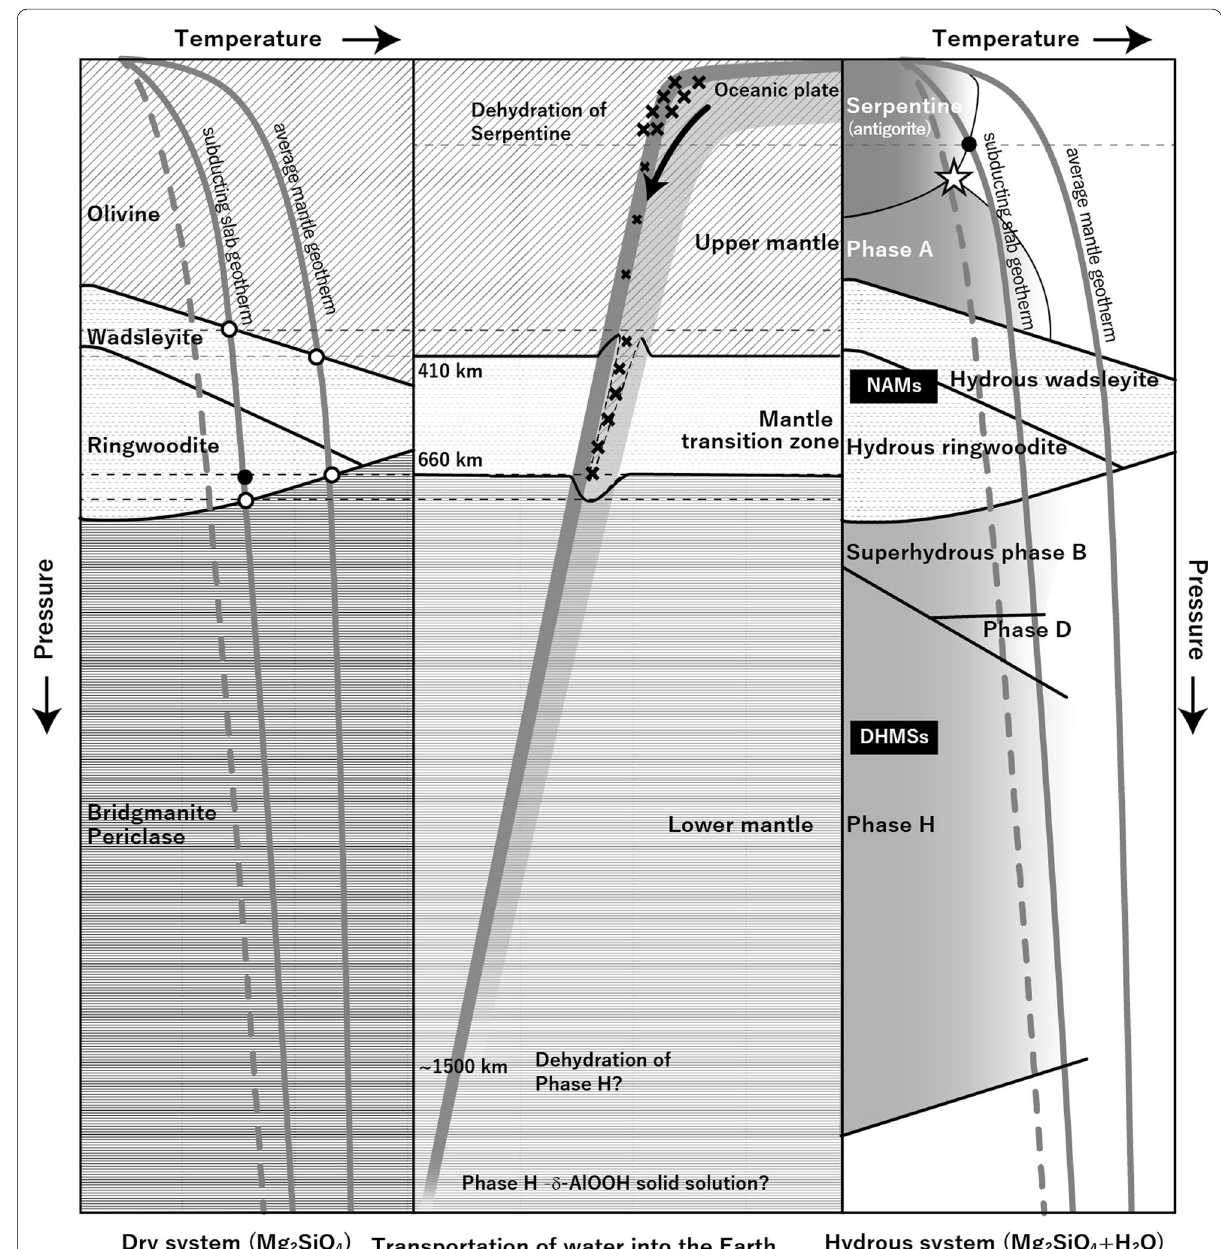
Fig. 1 Schematic illustration of the subducting slab (middle) and phase diagram of dry Mg 2 SiO 4 (left) and “stability diagram” of wet systems (right). More detailed stability diagrams of hydrous phases are given in Ohtani et al. (2001b); Nishi et al. (2014); Ohtani (2020). The cross symbols indicate the seismicity observed in the subducting oceanic plate. The “choke point” is shown as the star symbol. Below the choke point temperature, hydrous mineral can transport water into the deeper part of the Earth’s